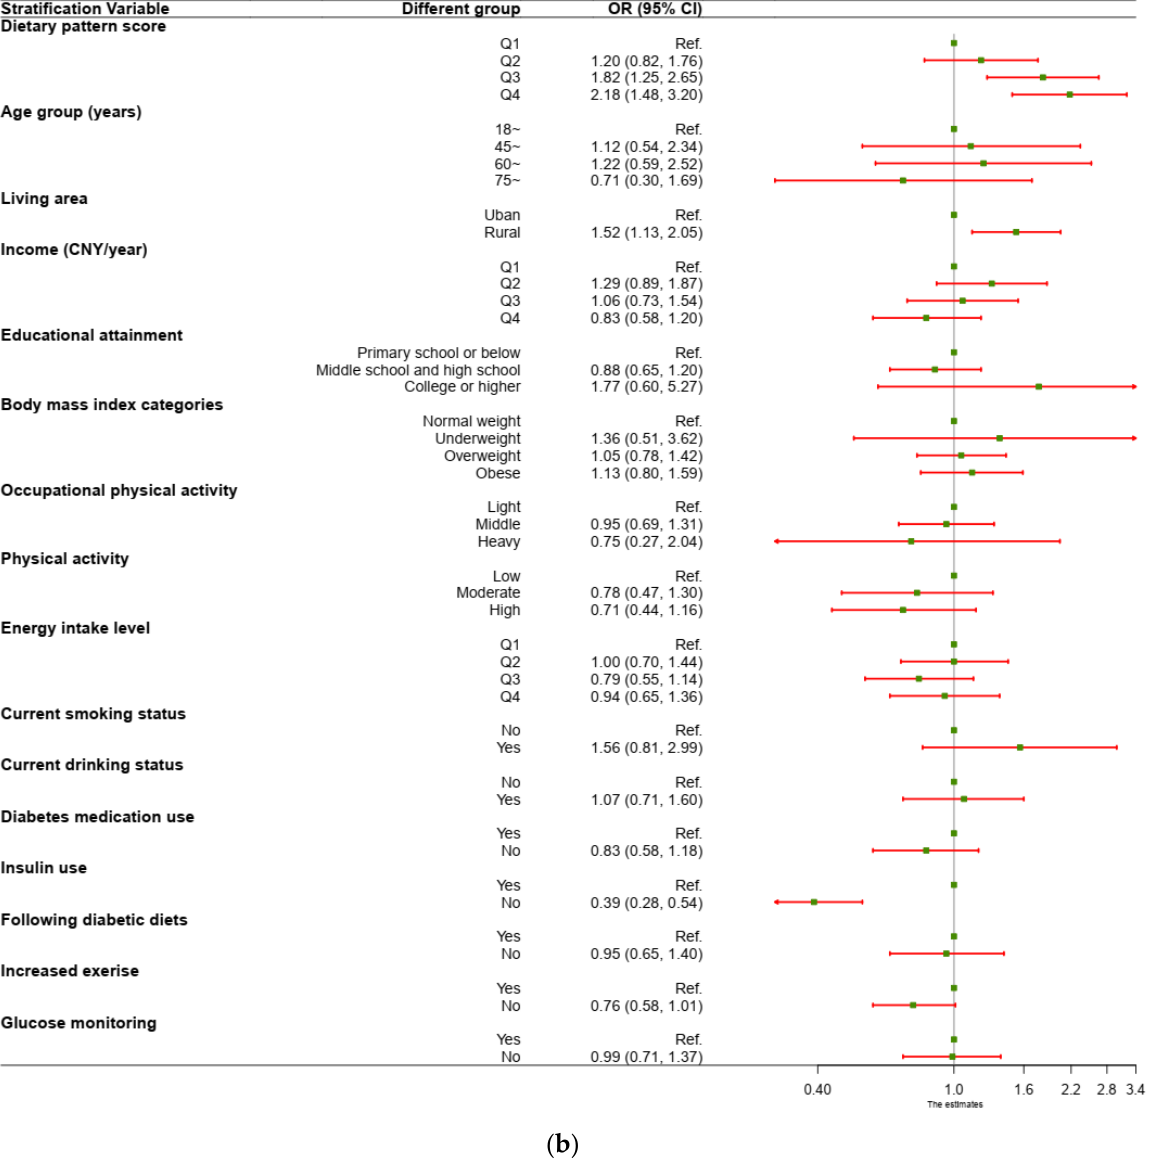
Figure 2. ( a ) Multiple-variable-adjusted association between dietary pattern and the risk of poor glycemic control for male participants. ( b ) Multiple-variable-adjusted association between dietary pattern and the risk of poor glycemic control for female participants.